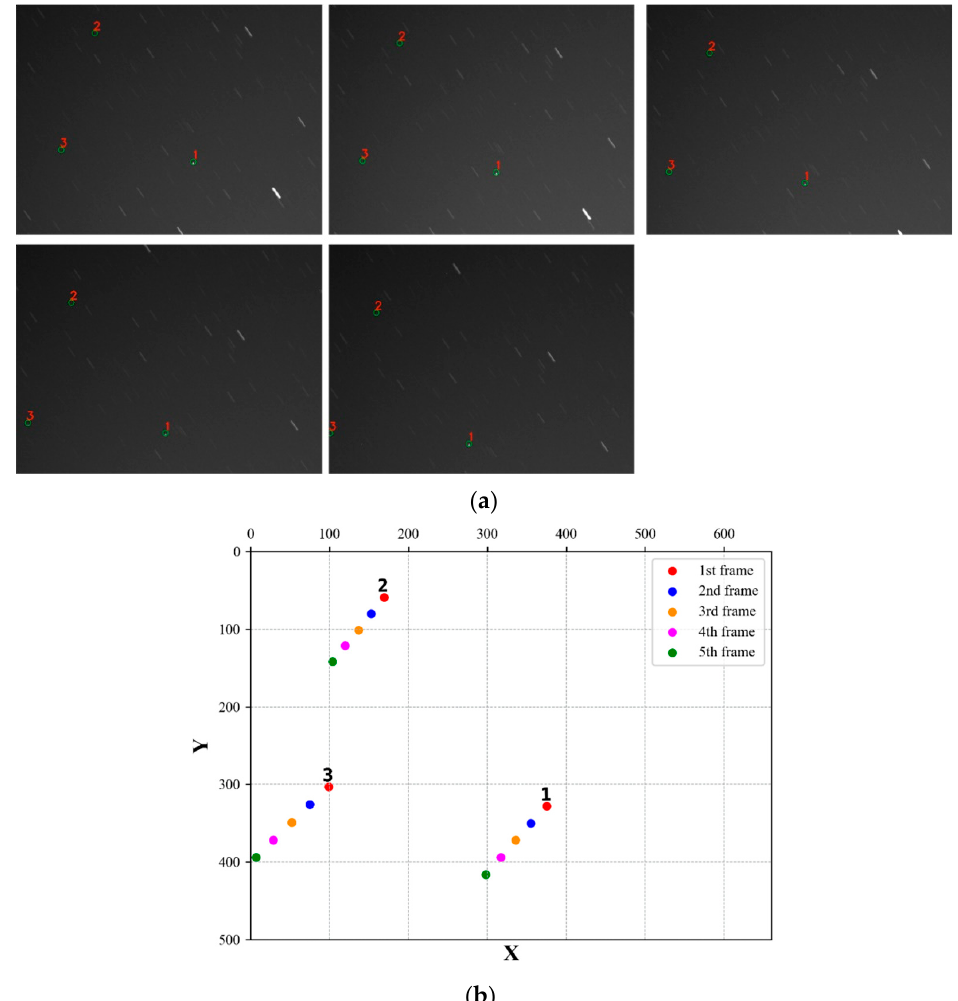
Figure 2. An example image sequence of the SpotGEO dataset. ( a ) The typical sequence that captures three objects. ( b ) Object detection in a sequence of 5 consecutive frames. The source positions are shown by the circle symbols in different colors.